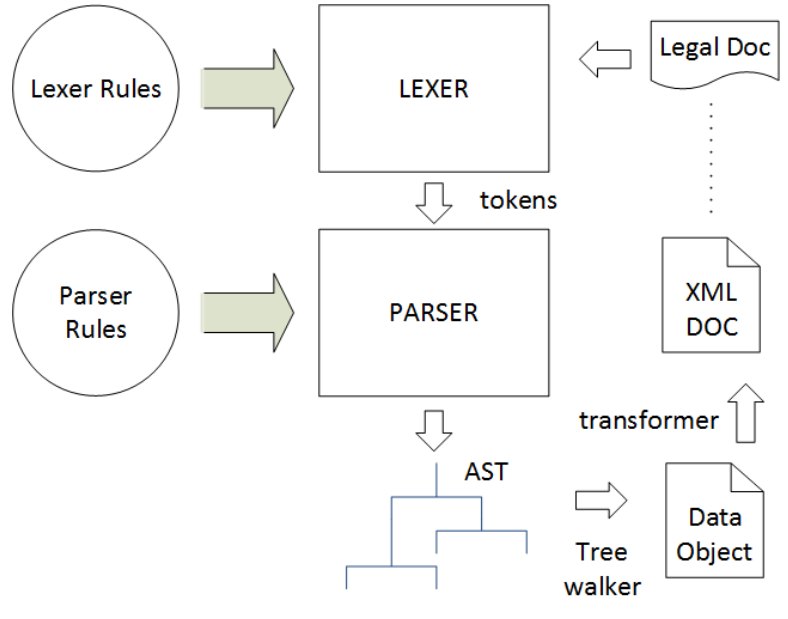
Figure 9. Overview of Legal Document Structure Parser